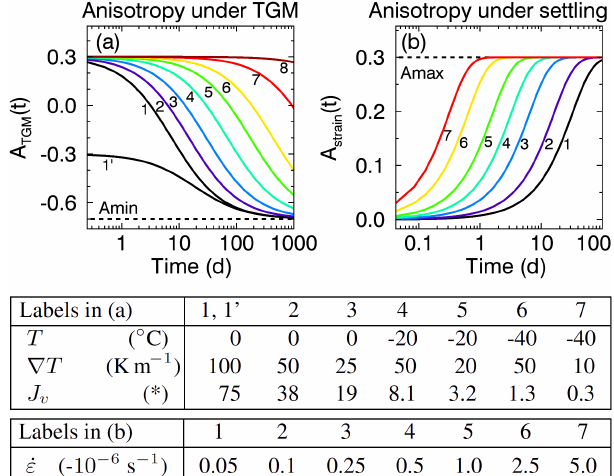
Figure 2. Modeled anisotropy evolution for TGM with α 1 = 1 . 01m 2 kg − 1 and settling with α 2 = 1 . 68 for the different tabled conditions (1–7). In (a) , 1 and 1 (cid:48) differ only by the initial anisotropy. The dark red line (8) corresponds to ∇ T = 100Km − 1 and T = − 80 ◦ C. The vapor flux J v is given ( ∗ ) in units of 10 − 8 kgm − 1 s − 1 .